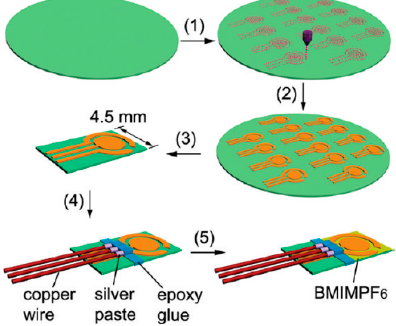
Figure 17. Procedures employed for the inkjet printing of gold electrode arrays on MCE membranes to fabricate paper-based solid-state electrochemical oxygen sensors: ( 1 ) Inkjet printing of GNP patterns; ( 2 ) growth of GNP patterns into gold electrode arrays; ( 3 ) cutting a PGEA from its ensembles; ( 4 ) electric connection and size control of a PGEA; and ( 5 ) addition of BMIMPF6 from the back MCE side of a PGEA to fabricate the oxygen sensor [132].